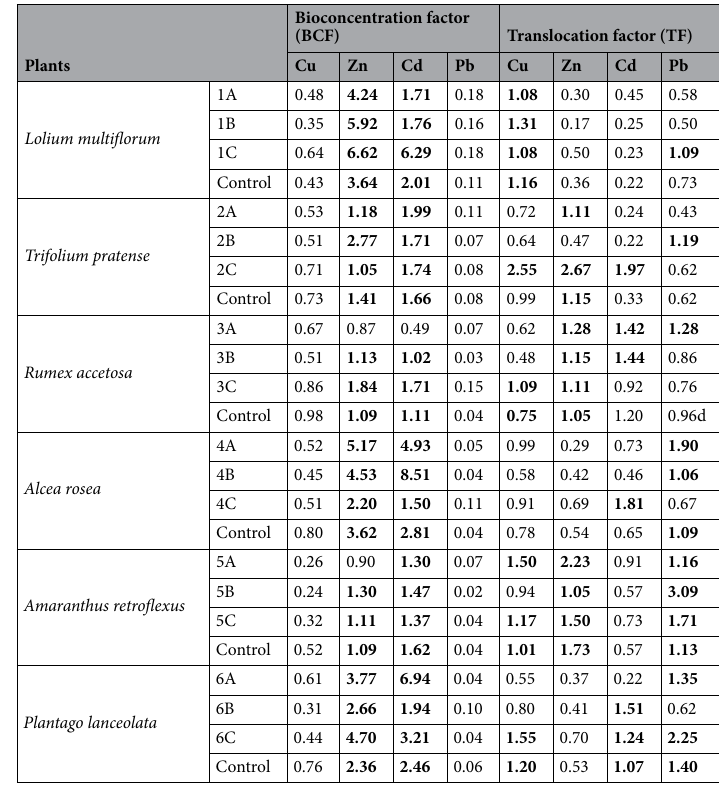
Table 1. The bioconcentration (BCF) and translocation factor (TF) of Cu Zn, Cd and Pb in plant species from research sites (abbreviations see “Materials and methods”). Where: in BCF the highlighted values mean concentration in roots biomass and in TF the highlighted values means effective metals translocation within the